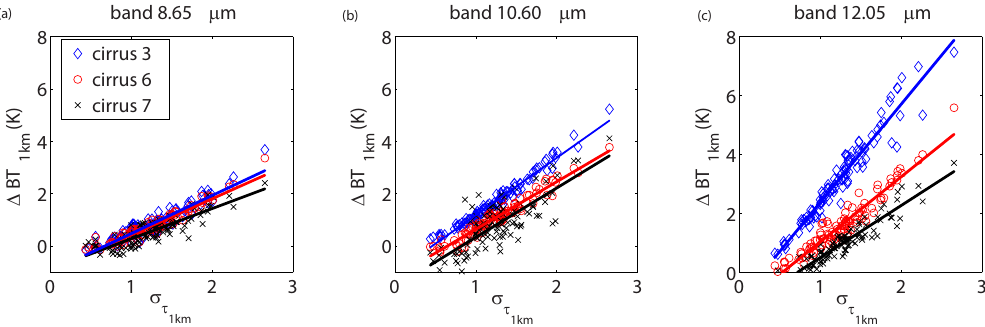
Figure 13. Brightness temperature differences, 1 BT 1km , viewed at the nadir as a function of the optical thickness standard deviation σ τ for the same three cirrus fields with different ice crystal effective diameters: cirrus 3 ( D eff = 9 . 95µm), cirrus 6 ( D eff = 20 . 09µm) and cirrus 7 ( D eff = 40 .